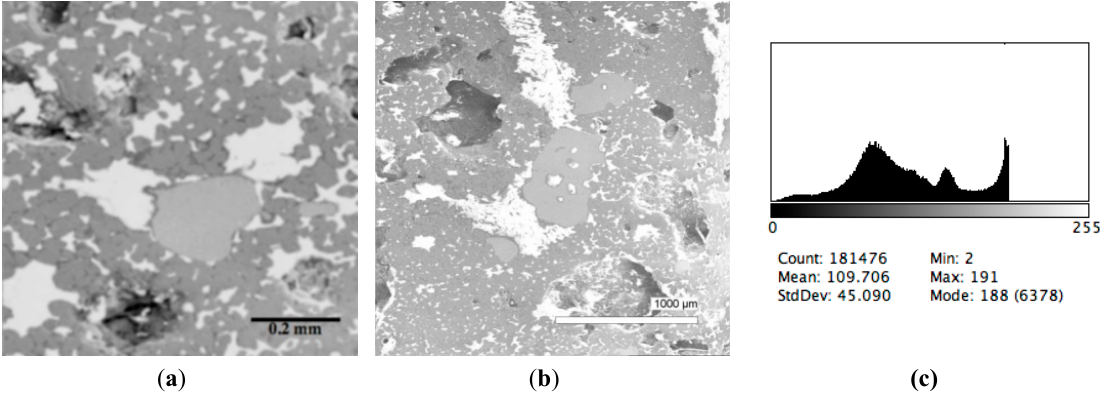
Figure 1. Typical back scattered electron images ( a , b ) of microstructures and contrast histogram ( c ) of the Sample #1 grind; scanning electron microscopy (SEM).